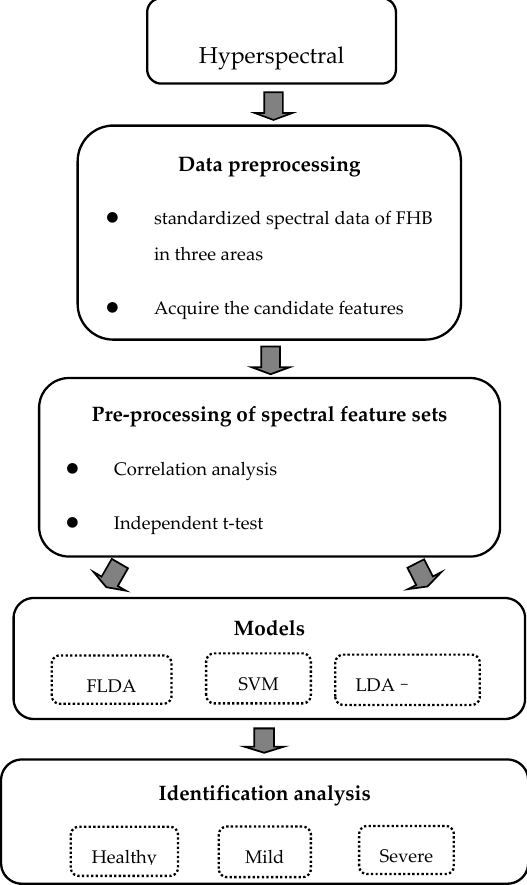
Figure 4. General workflow for identification of wheat Fusarium head blight; FLDA (fisher’s linear discriminant analysis); SVM (support vector machine); LDA–SVM (the combination of FLDA and SVM).